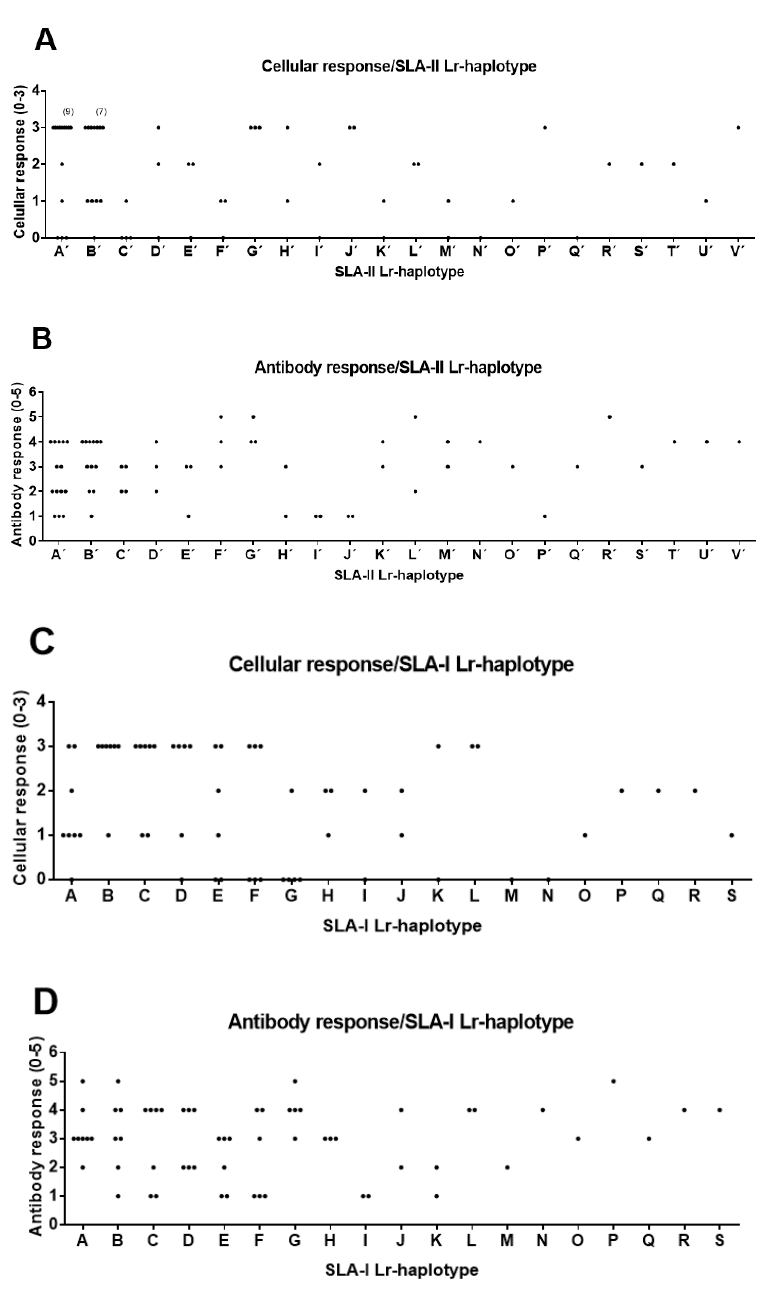
Figure 2. Correlations between SLA-I and SLA-II Low-resolution (Lr) haplotypes and the immune response elicited by dendrimer peptides in the 63 immunized animals (Group 0). Animal group composition as in Table S3. Antibody and cellular response values as in Table S2 and Figure S1. ( A ) Significant correlation of SLA-II Lr-haplotype and cellular response ( χ 2 α = 0.015 *, likelihood ratio chi-square (LR χ 2 ) α = 0.038 *, Cv = 0.66). ( B ) No correlation of SLA-II Lr-haplotype and antibody response ( χ 2 α = 0.102, LR χ 2 α = 0.634, Cv = 0.60). ( C ) Partially significant correlation of SLA-I Lr-haplotype and cellular response. ( χ 2 α = 0.053, LR χ 2 α = 0.046 *, Cv = 0.59). ( D ) No correlation of SLA-I Lr-haplotype and antibody response ( χ 2 α = 0.065, LR χ 2 α = 0.251, Cv = 0.57). VNT were categorized as 0: < 0.0; 1: > 0.9 and < 1.5; 2: > 1.5 and < 1.8; 3: > 1.8 and < 2.4; 4: > 2.4 and < 3; 5: > 3. IFN- γ secreting T cell values were categorized as: 0: < 50; 1: > 50 and < 90; 2: > 90 and < 140; 3: >